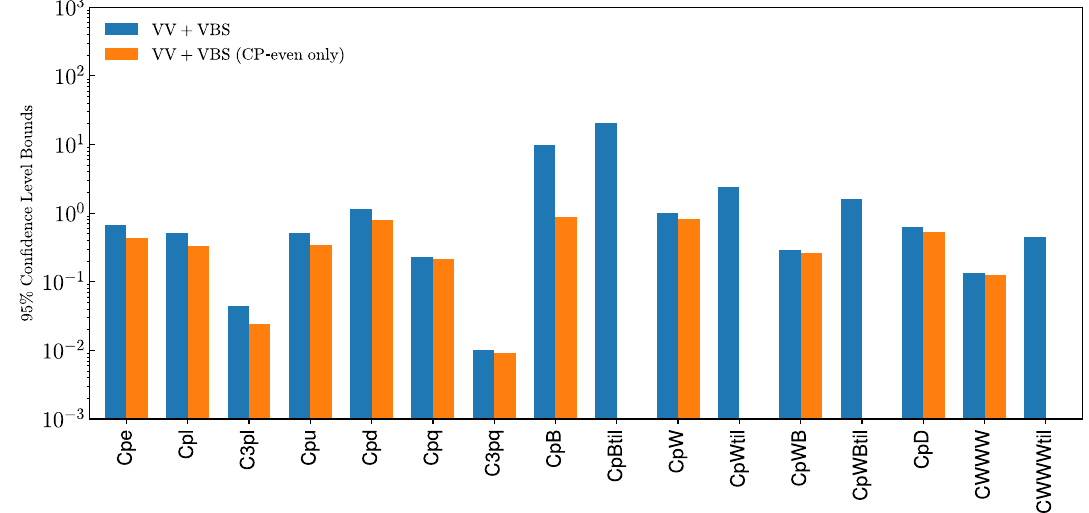
Fig. 27 Comparing the results of the baseline fit with those of the same fit where the CP-odd operators have been set to zero, such that only the CP-even ones remain Table 10 Overview of the (EW-induced) VBS HL-LHC projections considered in this analysis Final state